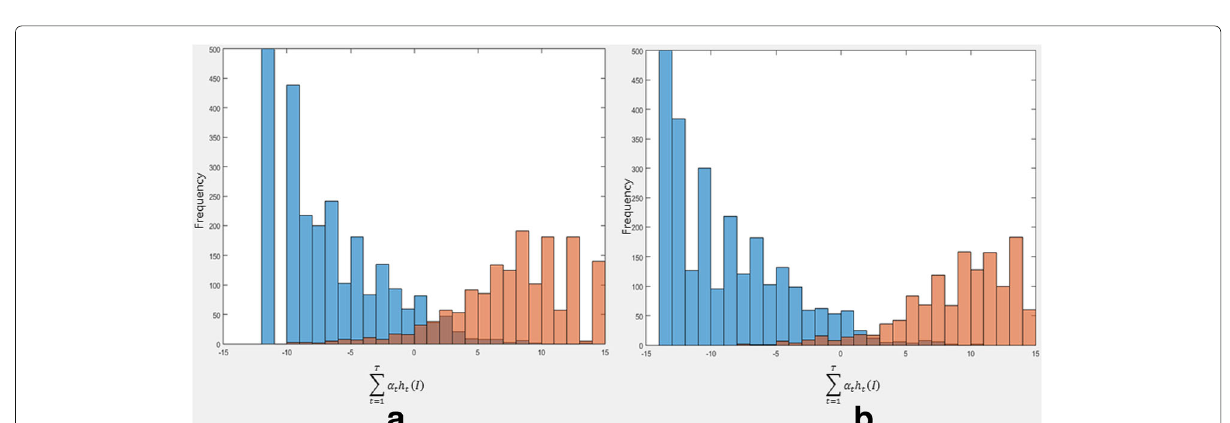
Fig. 7 Histogram of weighted sum of hypotheses in Eq. (3). a Viola-Jones [11]. b Suggested method